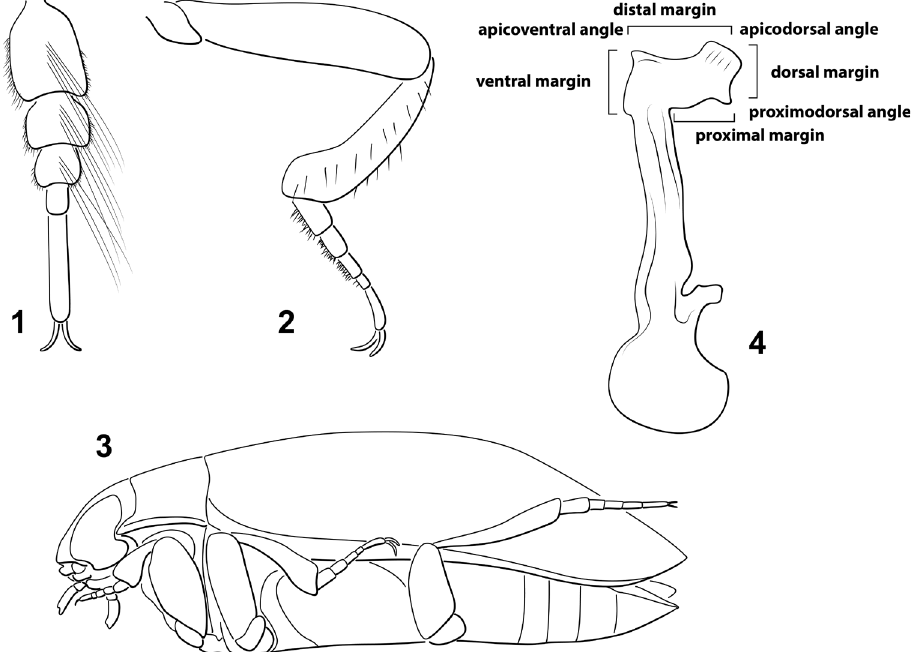
terior aspect 3 B. tibialis male, habitus, lateral aspect 4 B. rubellus , male median lobe, right lateral aspect showing regions referenced in diagnoses and